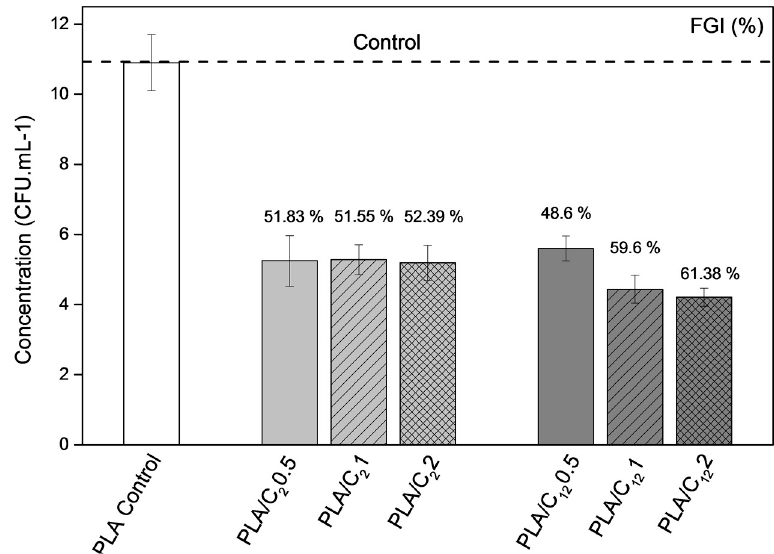
Figure 10. Antifungal activity against A. niger of PLA film (control sample), PLA/C 2 and PLA/C 12 bionanocomposite films. The value on the top of each bar corresponds to the fungal growth inhibition (FGI, %). Error bar corresponds to standard deviation (SD, n = 4).